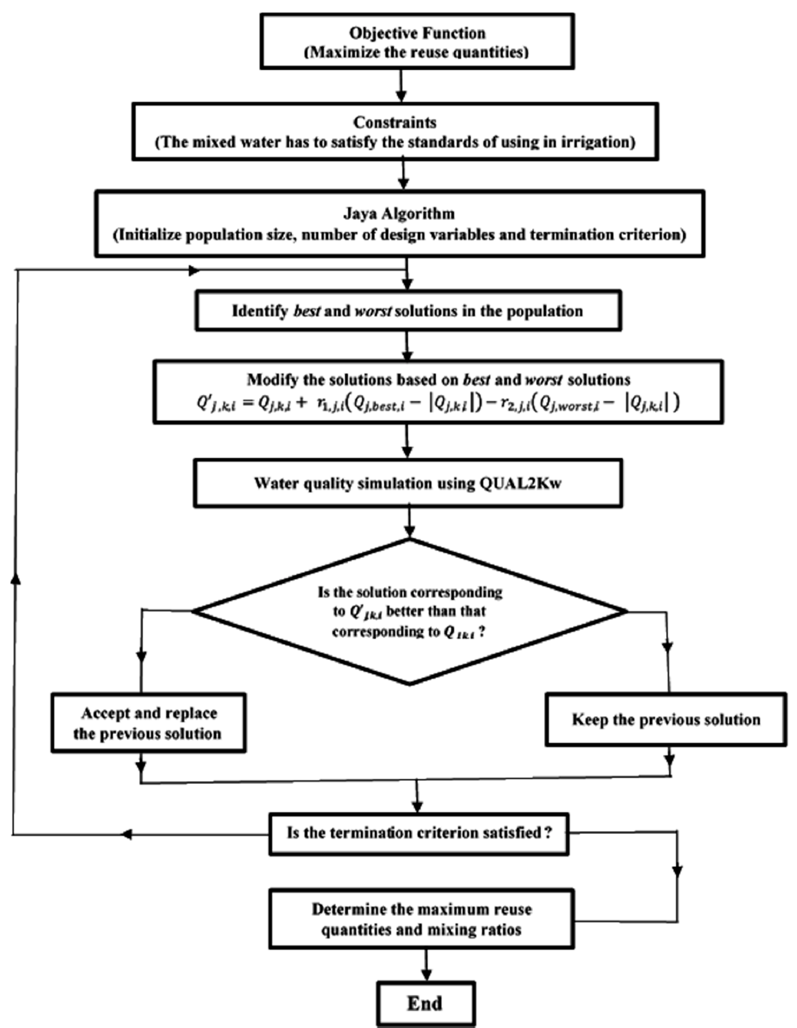
Figure 3. Flowchart of the optimization model.